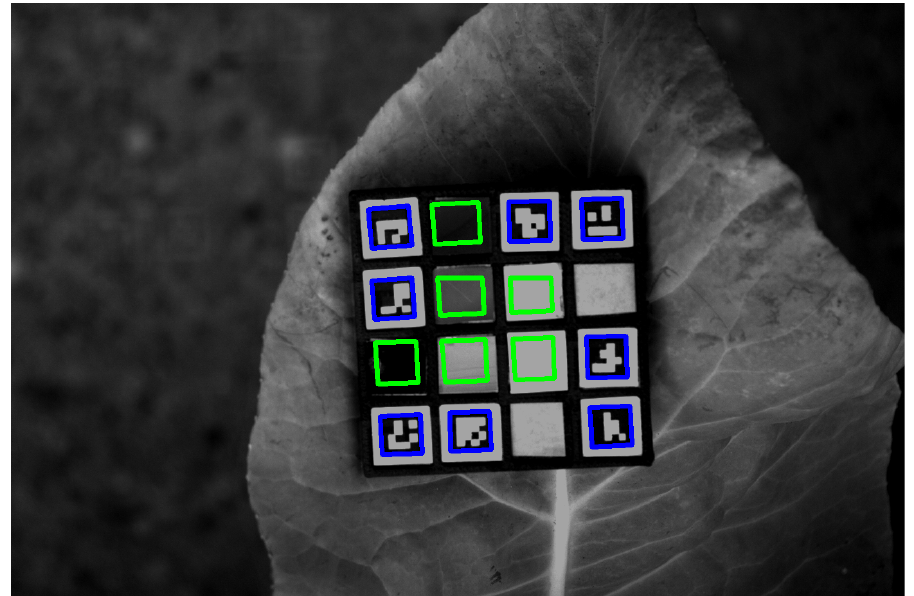
Figure 4. Image normalization using calibration plate. Physiological index calculation: For each pixel in the synchronized, 3D-morphed and normalized multispectral set we calculated a set of 18 physiological indexes.